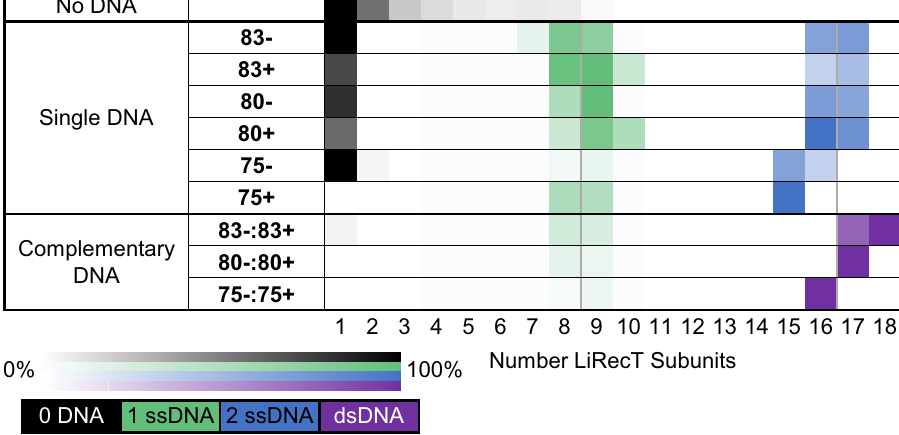
heat maps indicate the relative intensities of all species present in each decon- volved spectrum (Supplementary Figs. 15 and 16 and Supplementary Table 2). The coloringcorrespondstotheDNApresentineachcomplex:blackto0ssDNA,green to1ssDNA,bluetotwocopiesofthesamessDNA(2ssDNA),andpurpletoonecopy each of two complementary ssDNAs (dsDNA). The data are provided in Supple- mentary Table